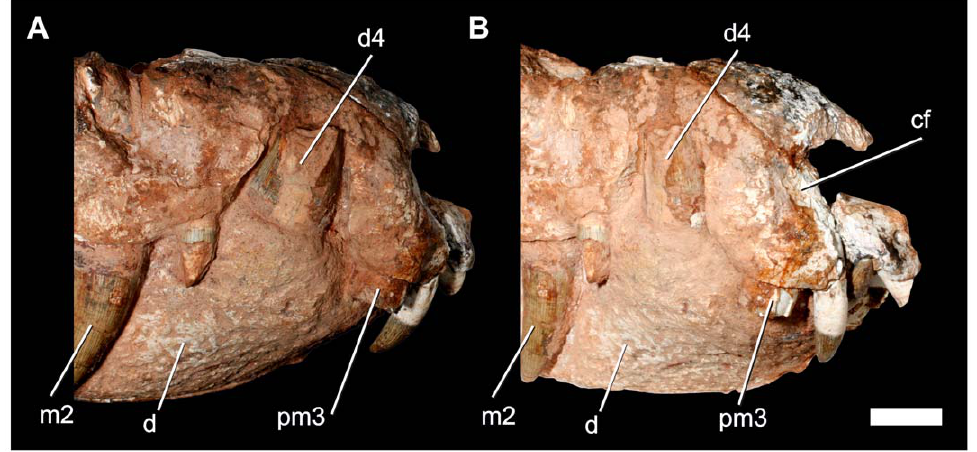
Figure 8. Details of the right anteriormost portion of the rostrum of Pissarrachampsasera (LPRP/USP 0018). A) lateral; B) anterolateral views. Abbreviation: cf, circumnarial fossa. Scale bar equals 1 cm.